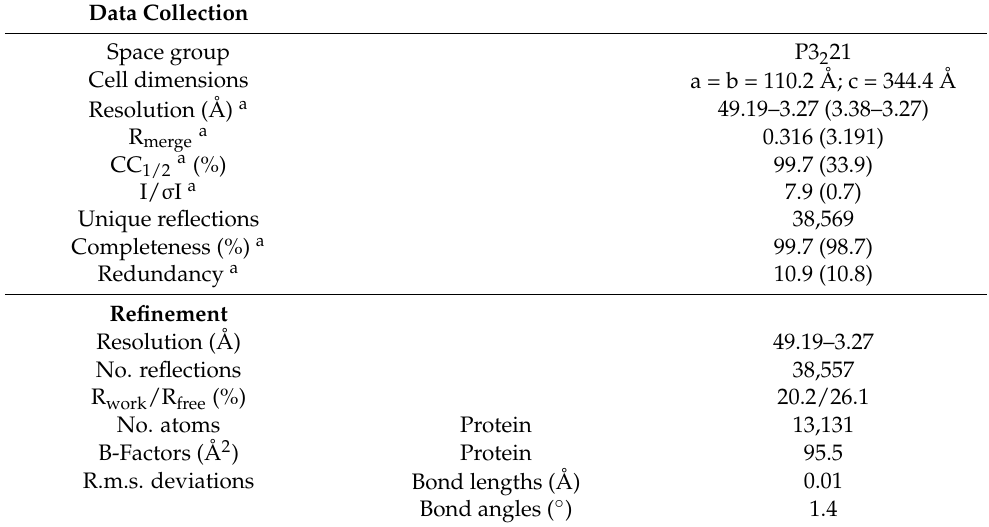
Table 3. Diffraction data and refinement